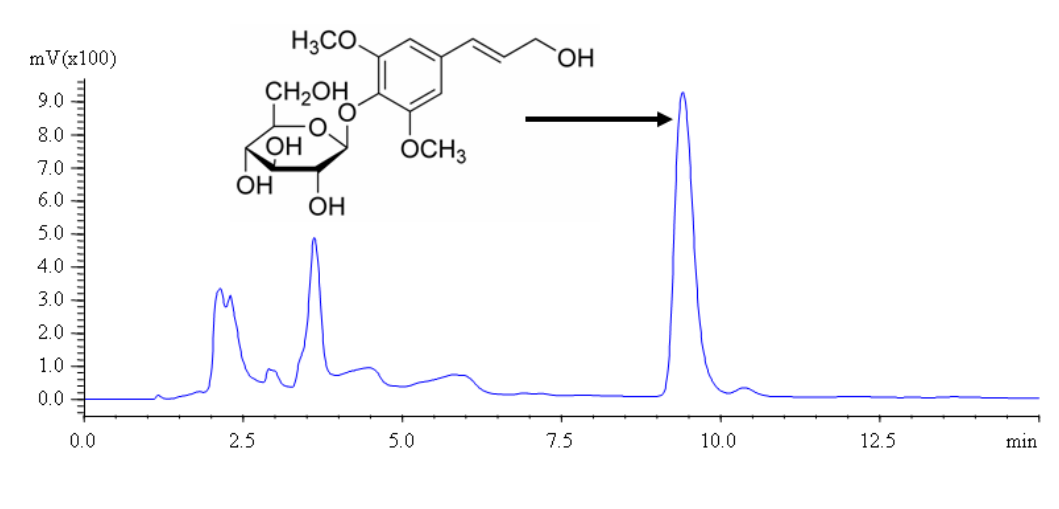
Figure 1. The structure and HPLC chromatogram of syringin in the bark of I. rotunda